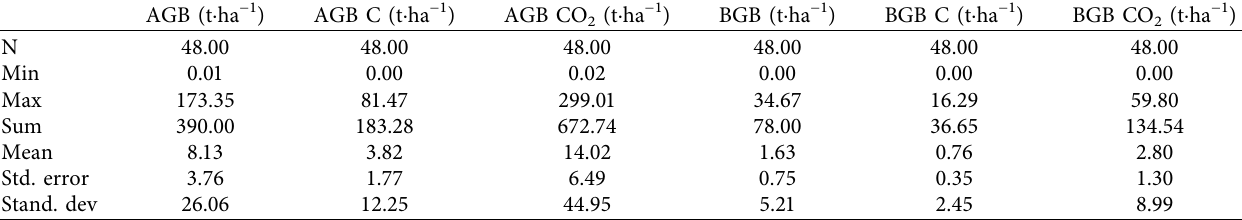
Table 2: Mean, maximum and minimum value of aboveground and belowground biomass, carbon stock, and carbon dioxide equivalent per tree spp. in Anshirava forest.